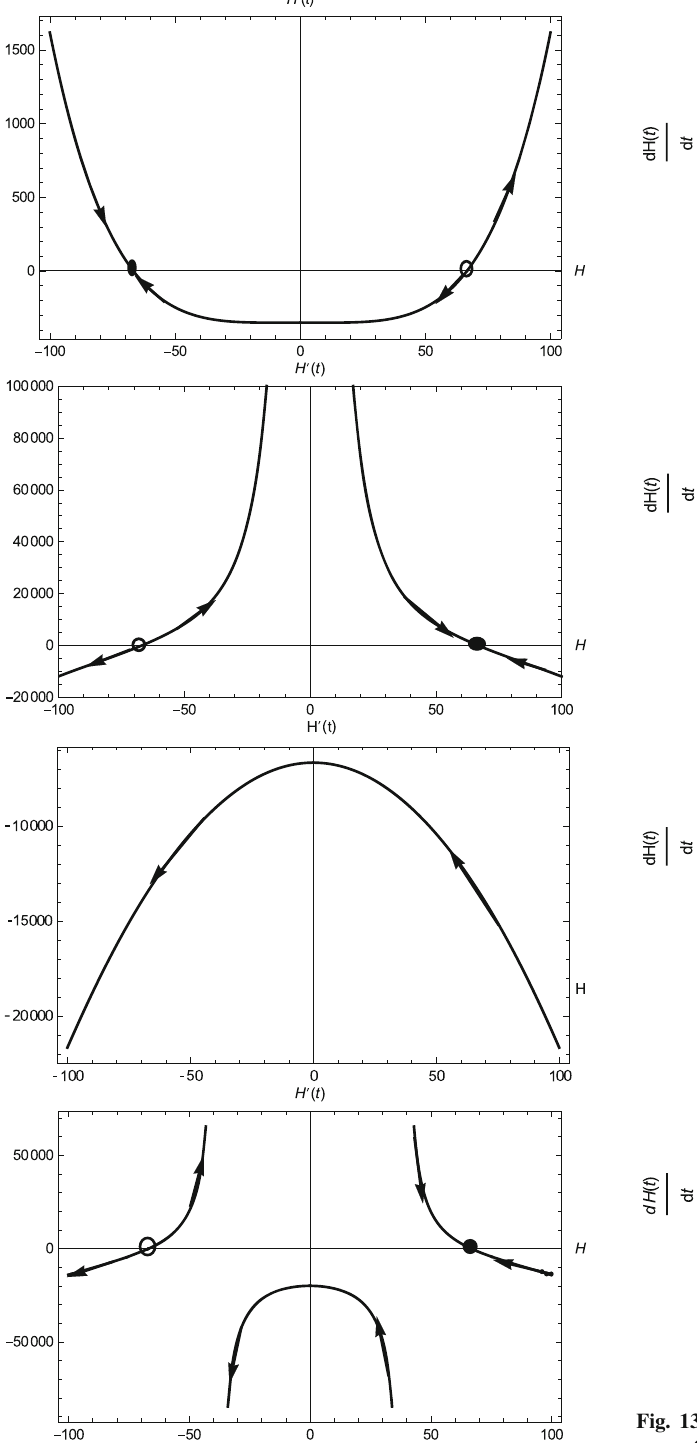
Fig. 12 Phase plot, or ˙ H vs H for different values of ω : The figure on the top is for (i) ω = − 0 . 9, λ = 0 . 01, C 1 = C 2 = 1, the second from the top is for (ii) ω = 1, λ = 100, C 1 = C 2 = 1, third is for (iii) ω = 0, λ = 100, C = C = 1, and bottom plot is for (iv) ω = 0 . 5, λ = 100, 1 2 C 1 = C 2 = 1